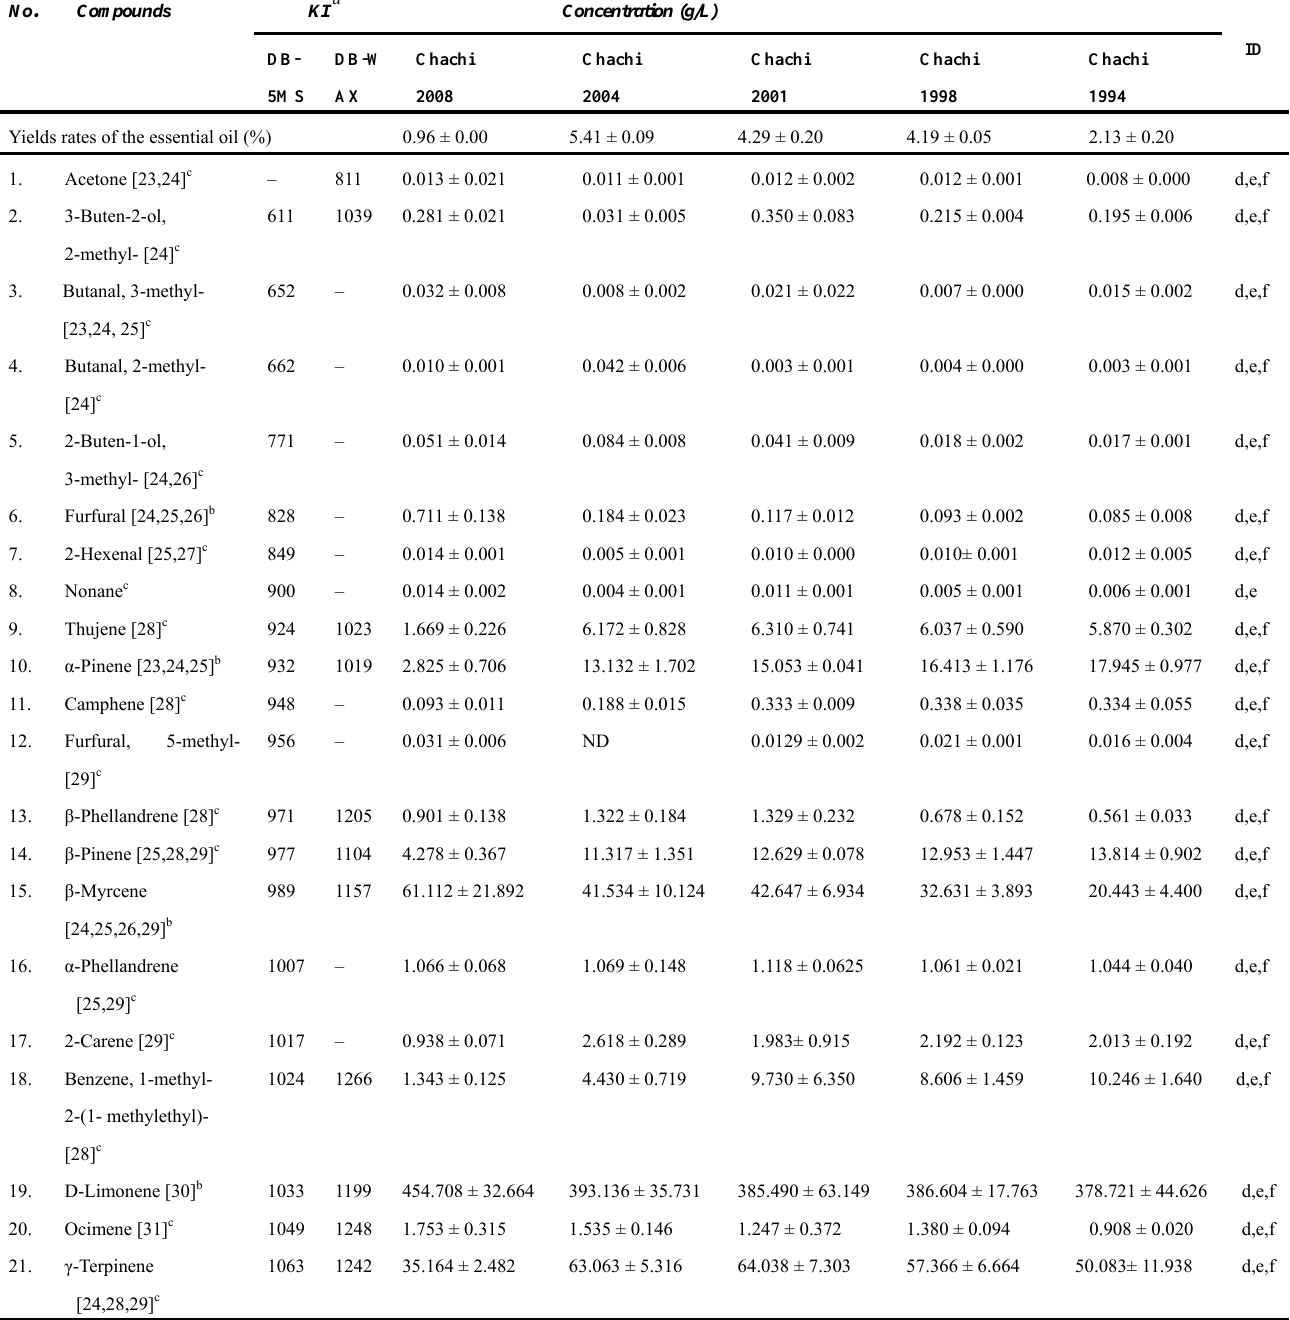
Table 1. Yield rates and chemical composition of PCR essential oil at different storage